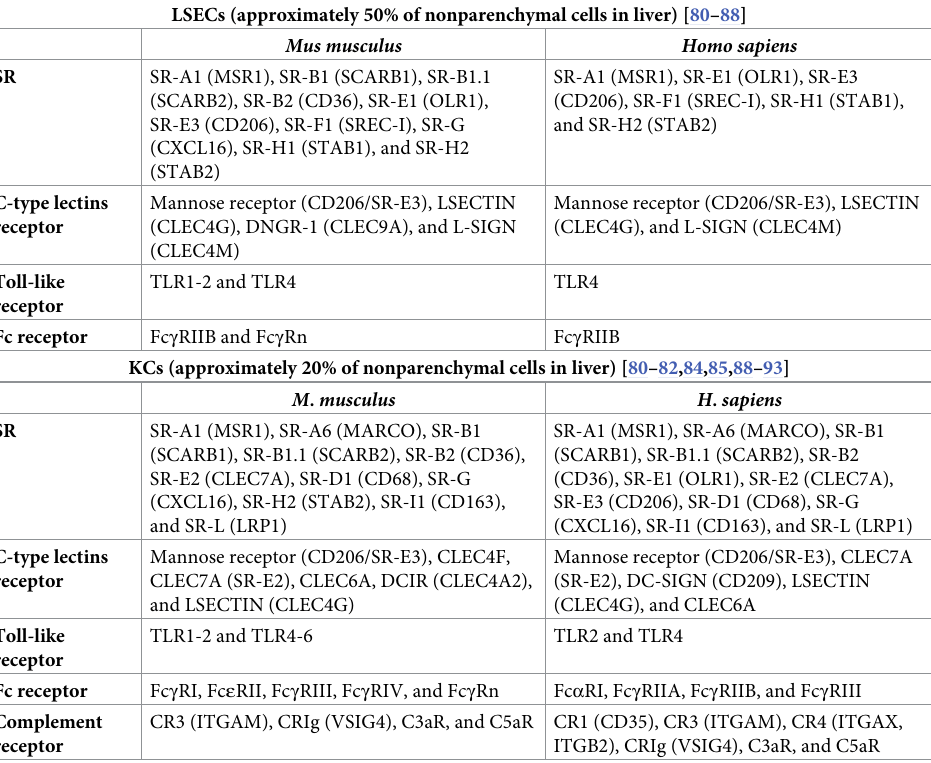
Table 2. Documented surface-expressed pattern recognition receptors of LSECs and